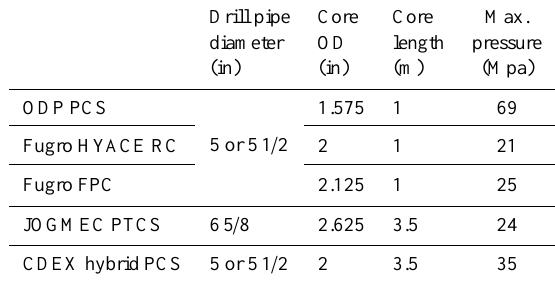
Table 1. Summary of available pressure-coring technique.